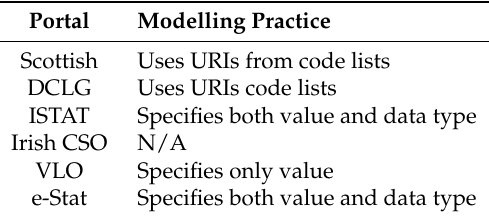
Specifies both value and data type